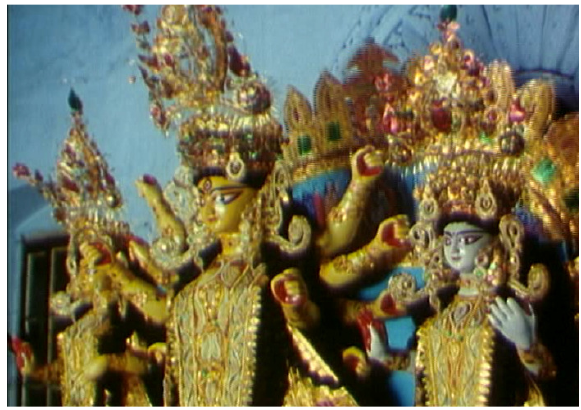
Figure 8. Chala being maneuvered into place, screen grab, Utsab